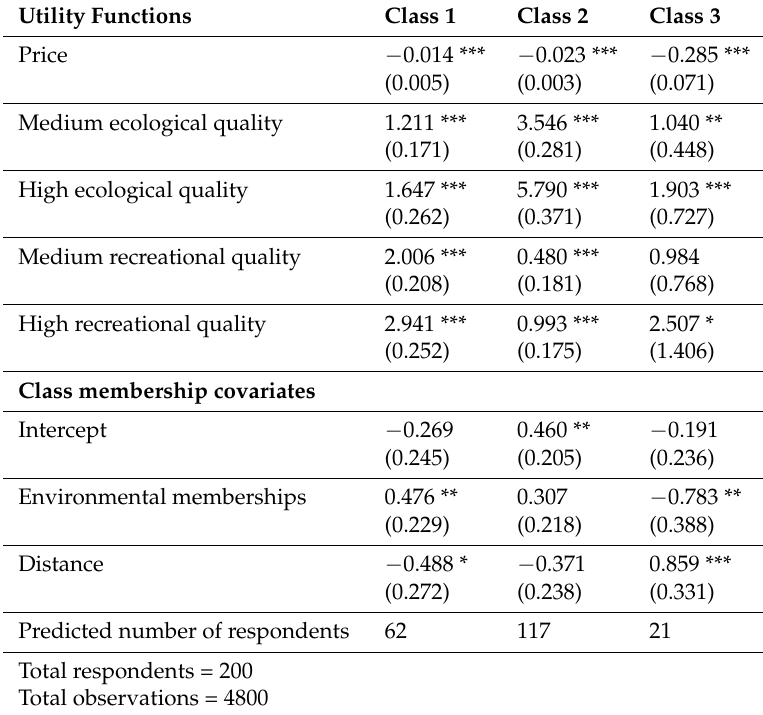
Table 3. Latent class model of water quality preferences.